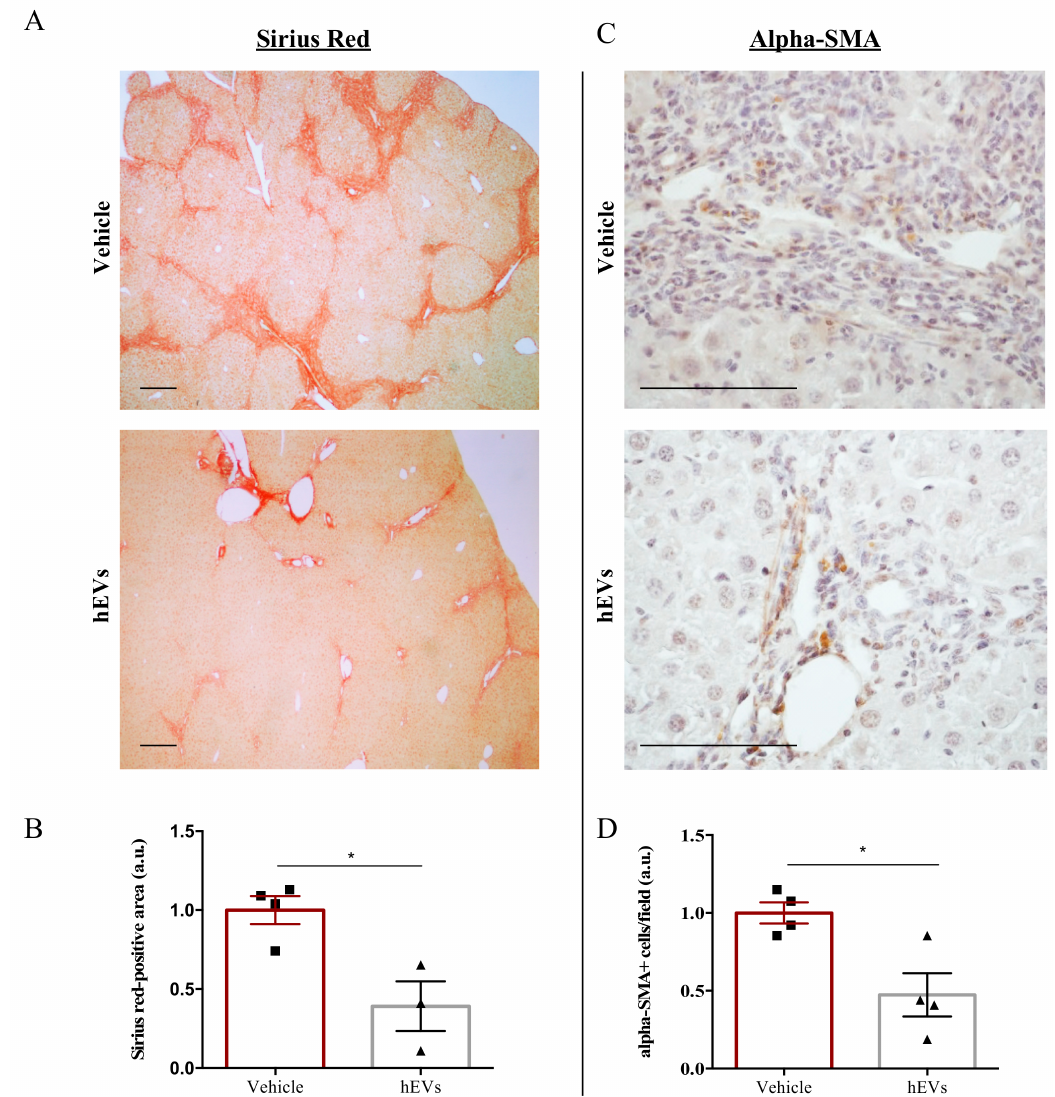
Figure 2. EV administration reduces liver fibrosis in FVB.Mdr2 − / − mice. ( A ) Representative images of connective tissue stain (Sirius red) in liver sections from FVB.Mdr2 − / − mice treated or not with EVs. Scale bar, 250 µ m. ( B ) Quantification of liver fibrosis in FVB.Mdr2 − / − mice injected with EVs relative to vehicle-treated mice. Graph shows percentage of fibrotic areas (Sirius red-positive areas) in FVB.Mdr2 − / − liver sections, normalized to vehicle-treated mice. Bars represent means ± s.e.m from at least 4 liver sections per animal ( n = 4 animals for vehicle, n = 3 animals for hEV treatment). * p < 0.05, Student’s t -test. ( C ) Representative images of α -SMA immunoreactivity in liver sections from FVB.Mdr2 − / − mice treated or not with EVs. Scale bar, 100 µ m. ( D ) Quantification of α -SMA immunoreactivity in FVB.Mdr2 − / − mice injected with EVs relative to vehicle-treated mice. Bars represent means ± s.e.m from at least 5 liver sections per animal ( n = 4 animals for vehicle, n = 4 animals for hEV treatment). * p < 0.05, Student’s